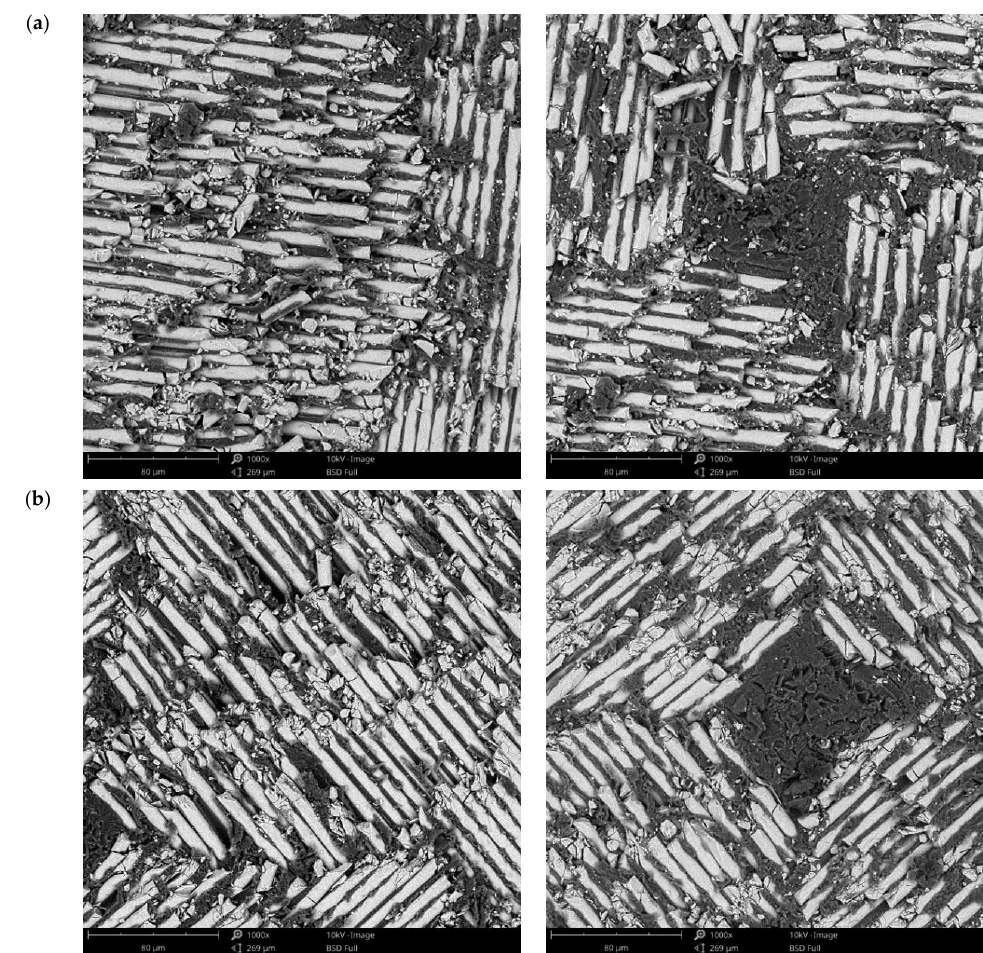
Figure 8. SEM images of the C1 sample surface after immersion tests at ( a ) 3 days and ( b ) 21 days in artificial saliva with varying pH (1000×).